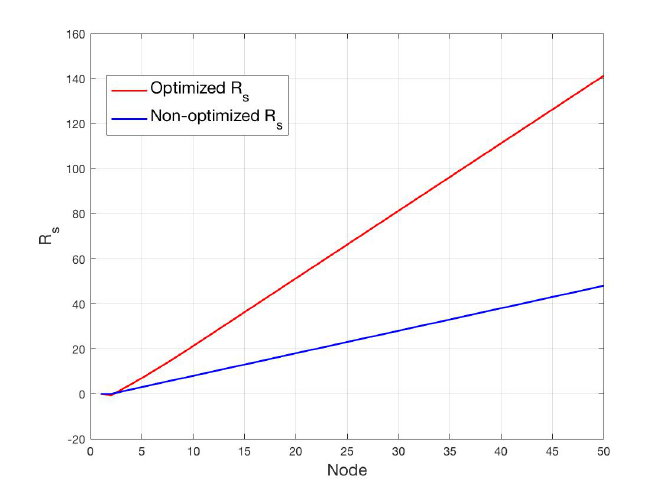
Figure 10. R s values for the optimized and non-optimized schemes for N =